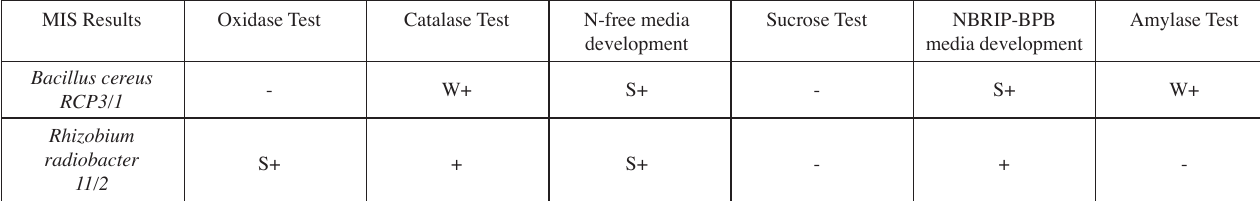
Tab. 1: Laboratory test results on the used isolates MIS